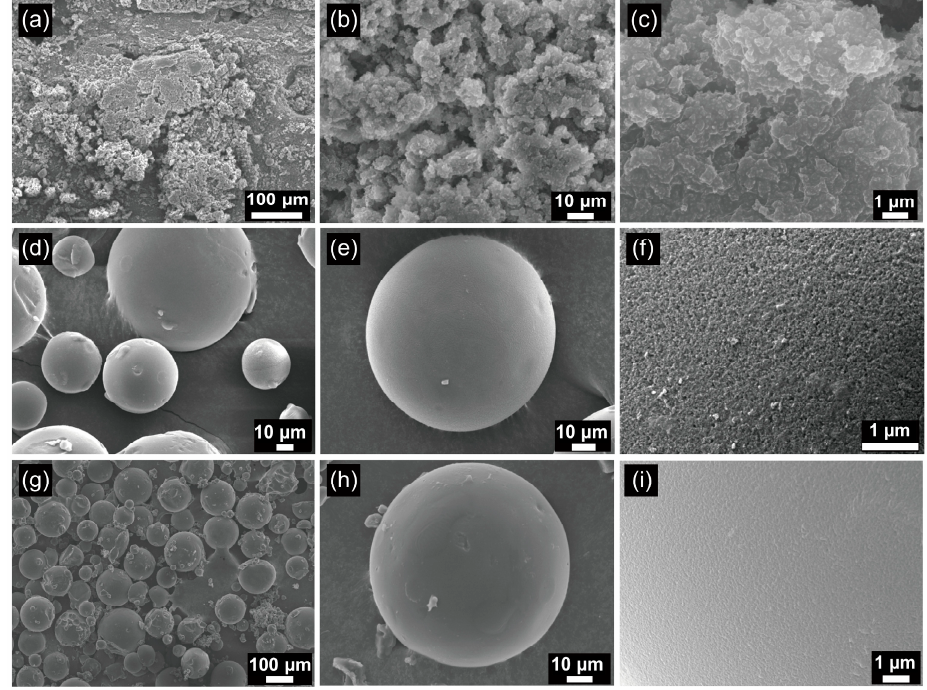
Figure 1. SEM micrographs of PIL (1)–NH 2 –GA–Lac ( a – c ), PIL (2)–NH 2 ( d – f ) and PIL (2)–NH 2 –GA– Lac ( g – i ).